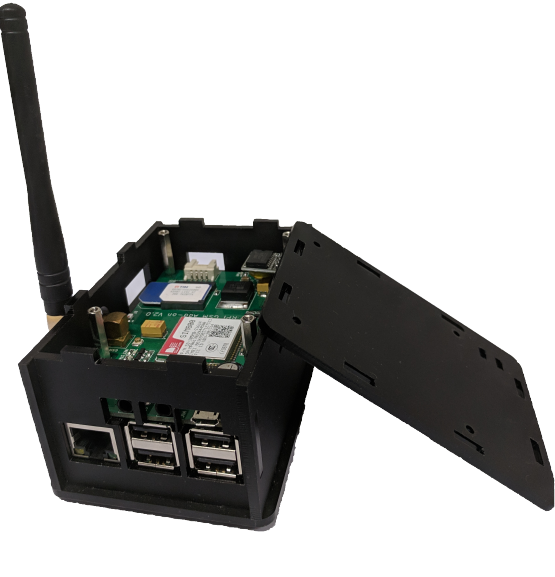
Figure 2. SWaMM smart metering device: SWaMM Edge Gateway, leveraging a Raspberry Pi 3 board with LTE